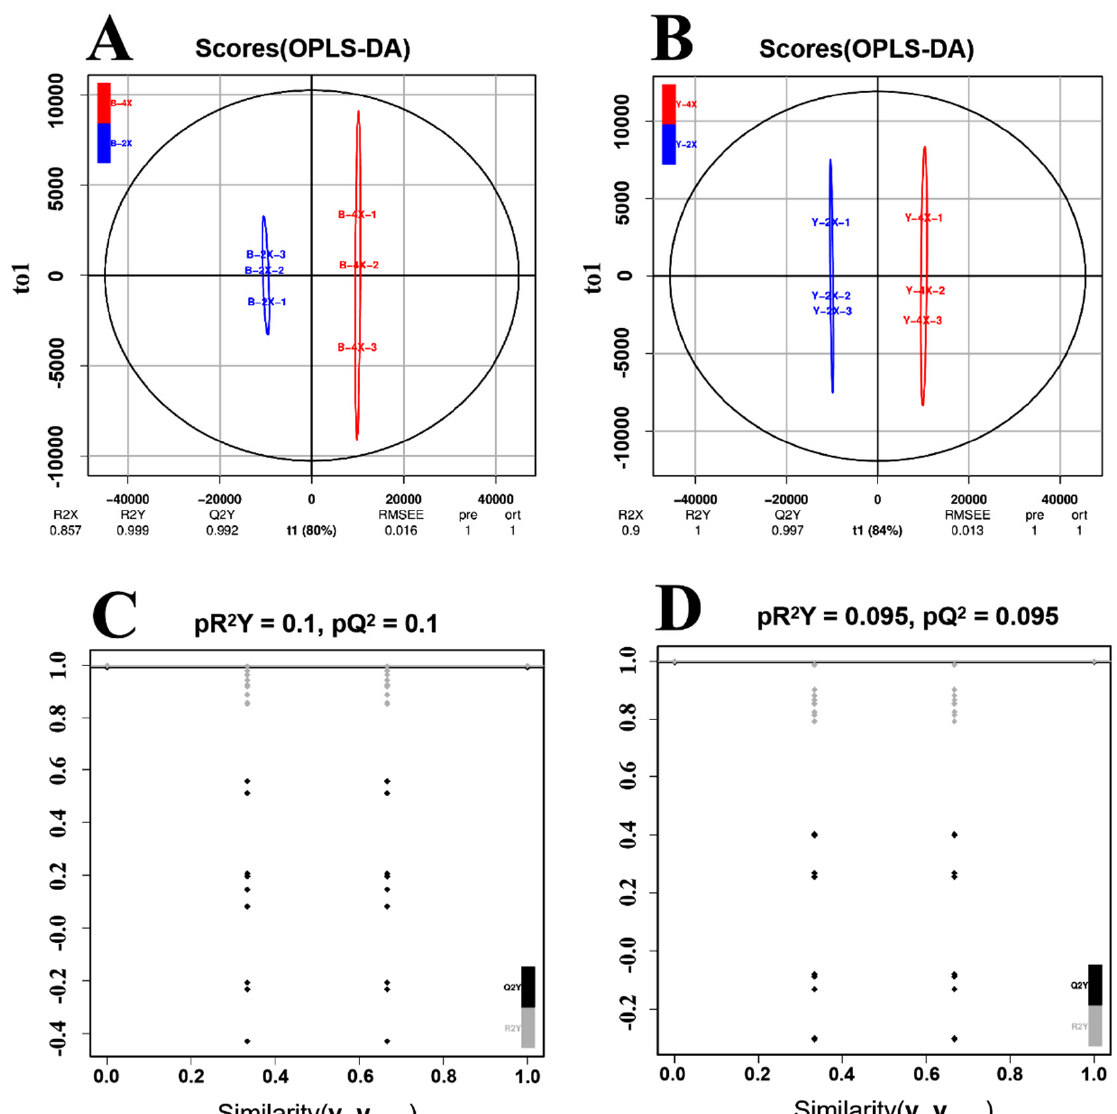
Figure 3. OPLS-DA scores and permutation verification. Scores of the OPLS-DA model with ( A ) Balilla-2 x vs. Balilla-4 x and ( B ) Yangdao 6-2 x vs. Yangdao 6-4 x . OPLS-DA permutation analysis model verification chart of ( C ) Balilla-2 x vs. Balilla-4 x and ( D ) Yangdao 6-2 x vs. Yangdao 6-4 x . R 2 Y and Q 2 represent the interpretation rate of the model to the Y matrix and the prediction ability of the model, respectively. A value closer to 1 means that the model is more stable and reliable, and when Q 2 > 0.9, the model is excellent. The horizontal line corresponds to the R 2 and Q 2 of the original model, and the black and gray points represent the R 2 , and Q 2 of the model after Y replacement,